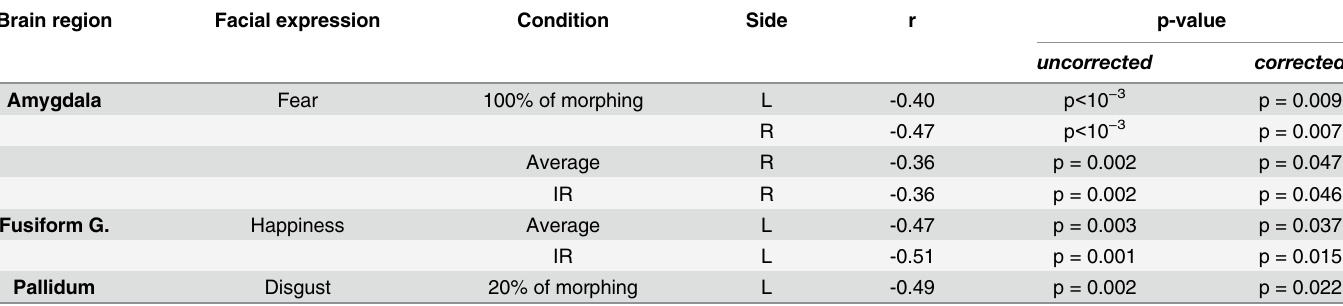
Table 2. Correlations between emotion recognition performance and regional volumes in the patient group. Brain region